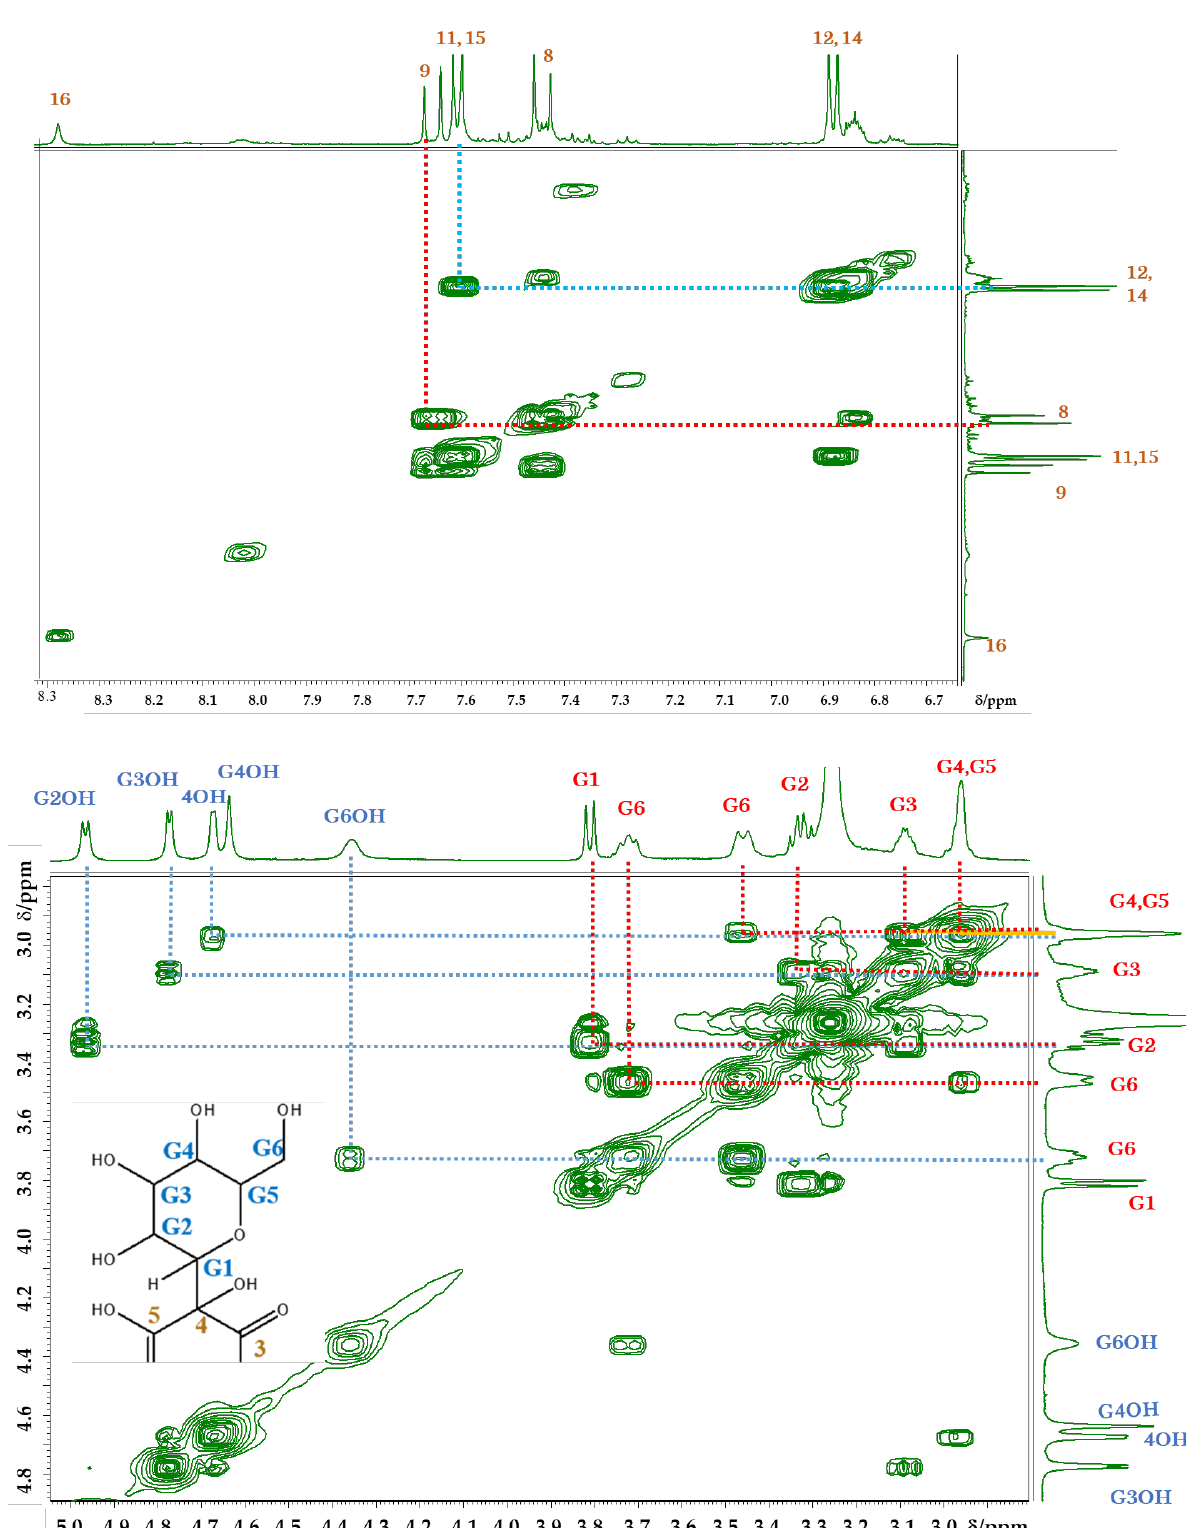
Figure 5. COSY spectra of carthamin potassium salt recorded in DMSO- d 6 at 30 ◦ C; cross-peaks between carbon atoms ( top ) and between carbon and oxygen atoms (bottom).